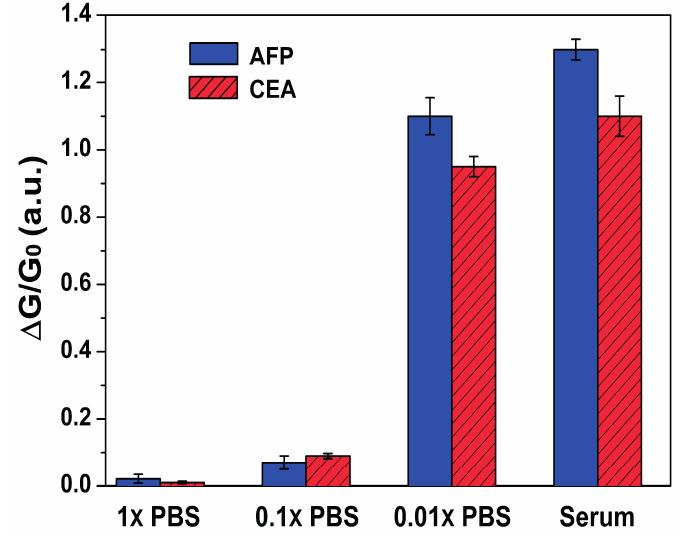
Figure 4. Biosensor responses to 100 pg/mL AFP and CEA in different PBS buffers and desalted serum